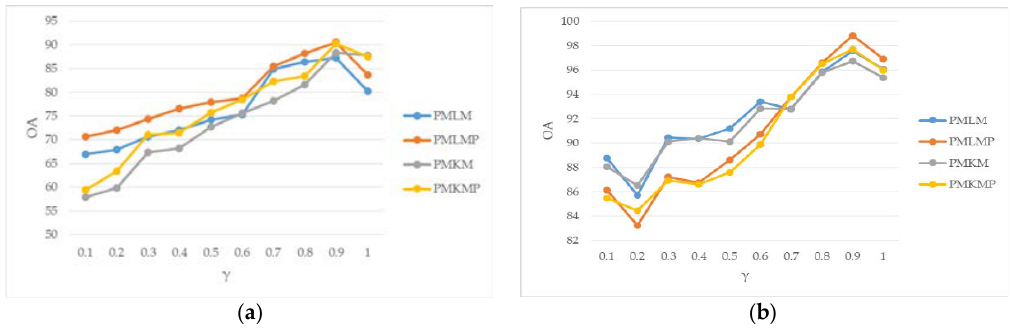
Figure 4. A line chart of classification results varying with relaxation parameter on two hyperspectral images (HSIs). ( a ) Indian Pines dataset; ( b ) Salinas dataset.